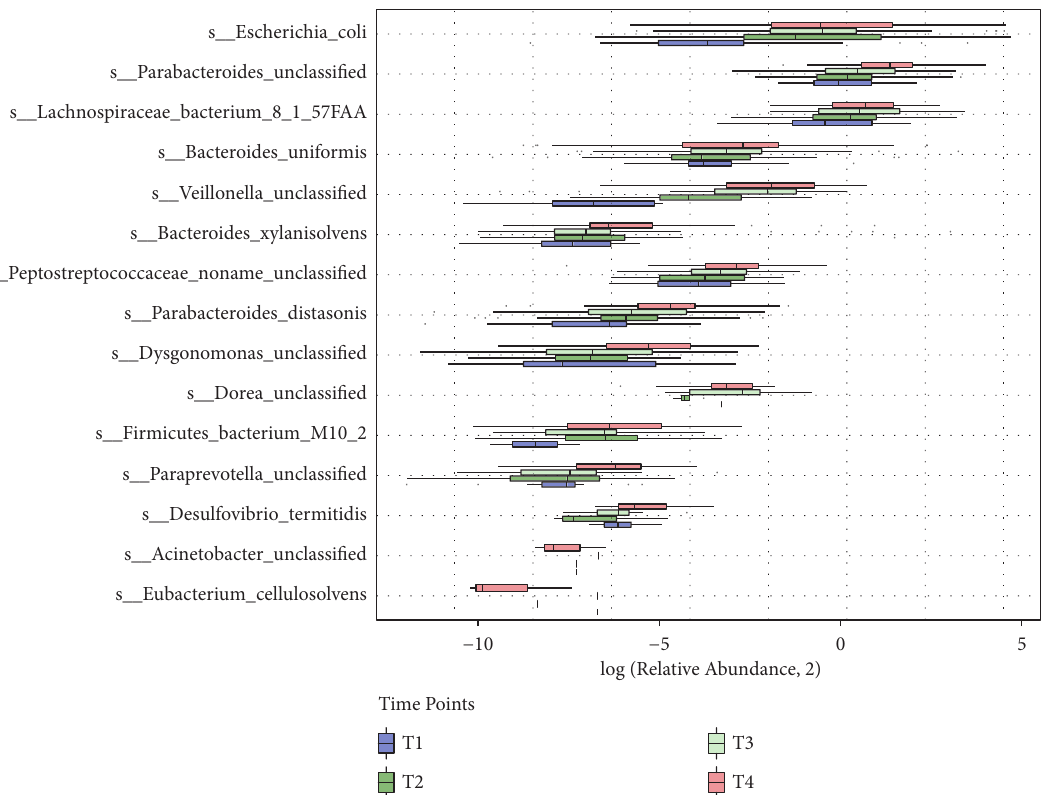
Figure 2: Alteration of the gut microbiota species abundance with significant differences in the OVX group at different time points after OVX surgery. This figure shows the results of the data analysis of the gut microbiota at the species level in the OVX group. The species that significantly differed in terms of abundance were determined by the Kruskal–Wallis test ( p < 0.05). The abscissa is the relative abundance plus a minimum value (1E-10), and then, the log2 value was calculated. The ordinate is four time points. Fifteen gut microbiota species had significantly different abundance between the two groups. The icons on the right represent different time nodes.